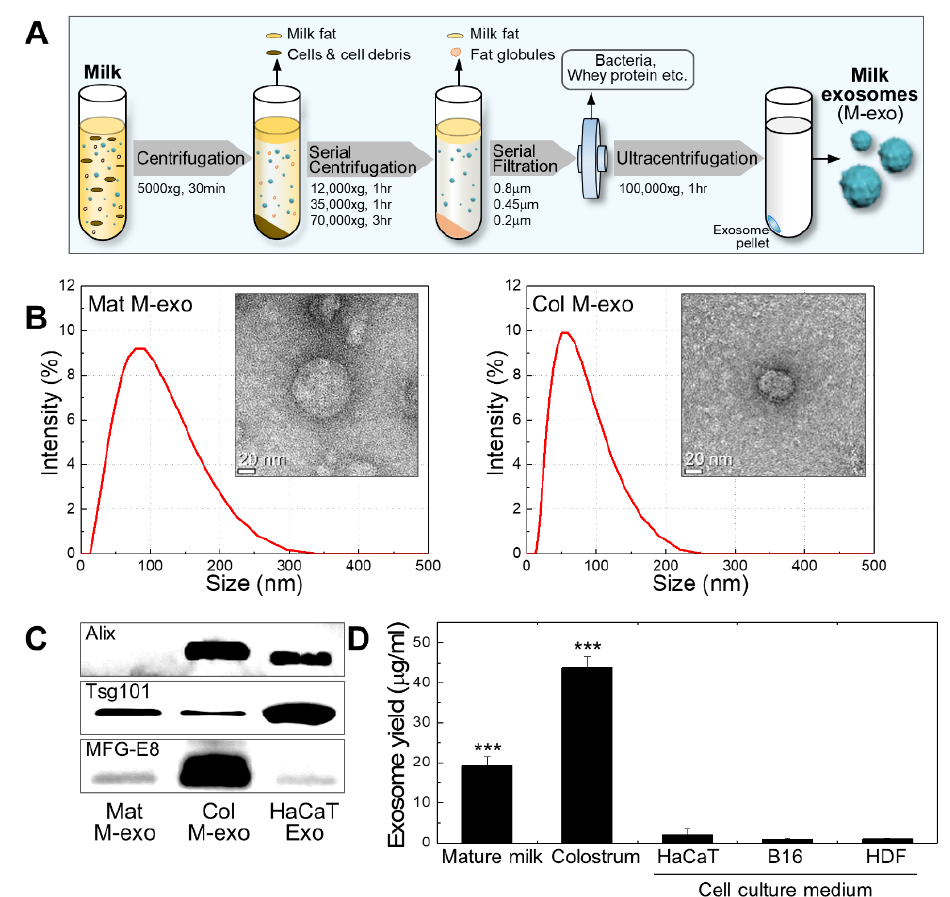
Figure 1. Extraction method and characterization of milk exosomes. ( A ) Schematic diagram of a method for extracting exosomes from milk. ( B ) Size distribution diagram and representative TEM image of Col M-exo and Mat M-exo. ( C ) Expression level of exosomal marker proteins, Alix, Tsg101, and MFG-E8, in various exosomes. ( D ) Comparison of exosome yield. Exosomes were extracted with an equal volume of cell-culture medium and milk. n = 5; *** p < 0.001 versus cell-culture me- dium.